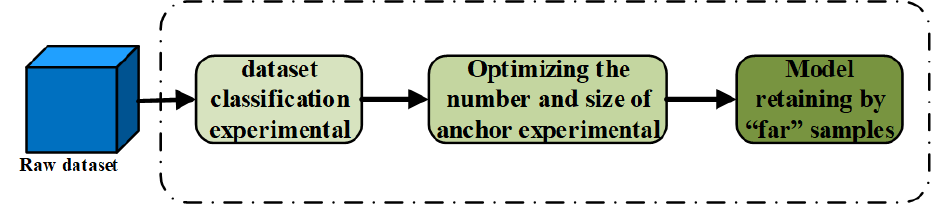
Figure 3. The proposed training method and steps to enhance YOLOv3 performance on UAV-viewed human